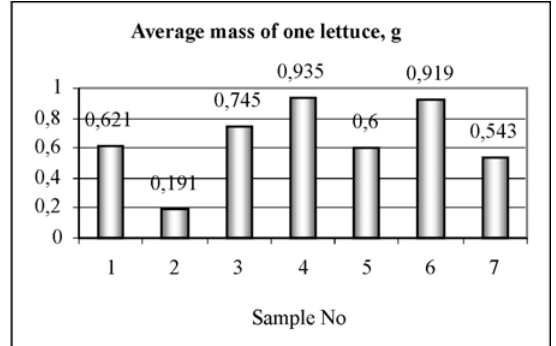
Fig 6. Lettuce average mass of plant in substrates of dif- ferent composition: 1 – peat substrate; 2 – soil; 3 – soil and sewage sludge 3:1; 4 – soil and sewage sludge 3:1 and 1,0 g K 2 SO 4 ; 5 – soil and sewage sludge 1:1; 6 – soil and sewage sludge 1:1 and 1,0 g K 2 SO 4 ; 7 – sewage